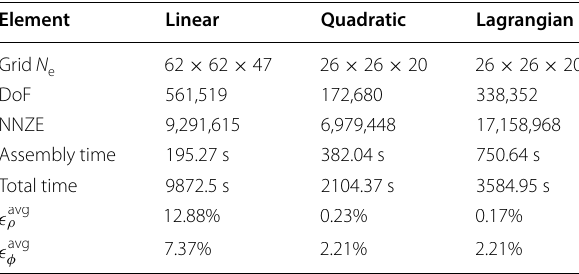
Times are shown in seconds, and the memory is presented in terms of the number of elements N e , the number of unknowns (DoF) and the number of non‑ zero entries for the global array NNZE. Average errors are shown for resistivity ǫ avg ρ , and for the phase ǫ avg φ